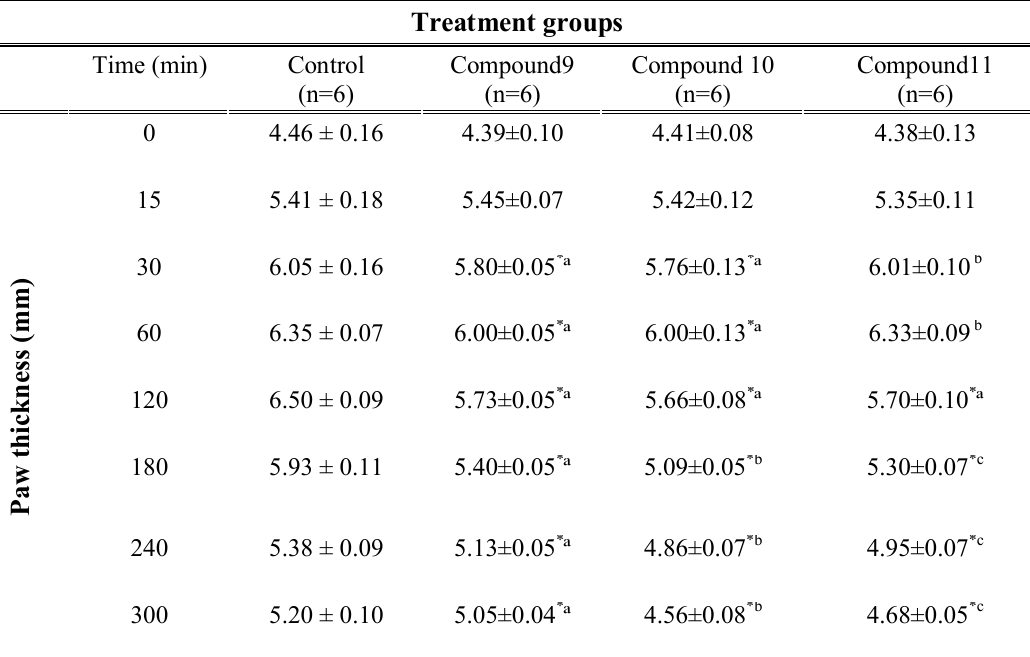
Table 2: Effect of Control and Compounds 9, 10 and 11 on egg-white induced paw edema in